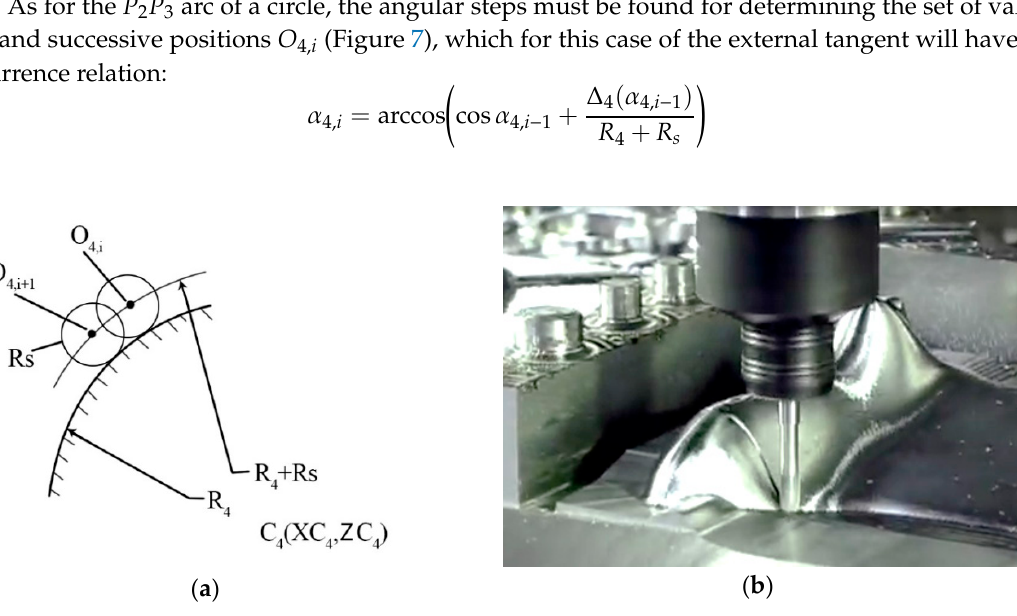
Figure 7. Successive positions of the reference point O 4 ,i corresponding to the overlapping planes, and the result of optimal control: ( a ) Successive positions of the tool reference point O 4 ,i ; ( b ) Constant geometric shape deviations with 2 ½ D control.